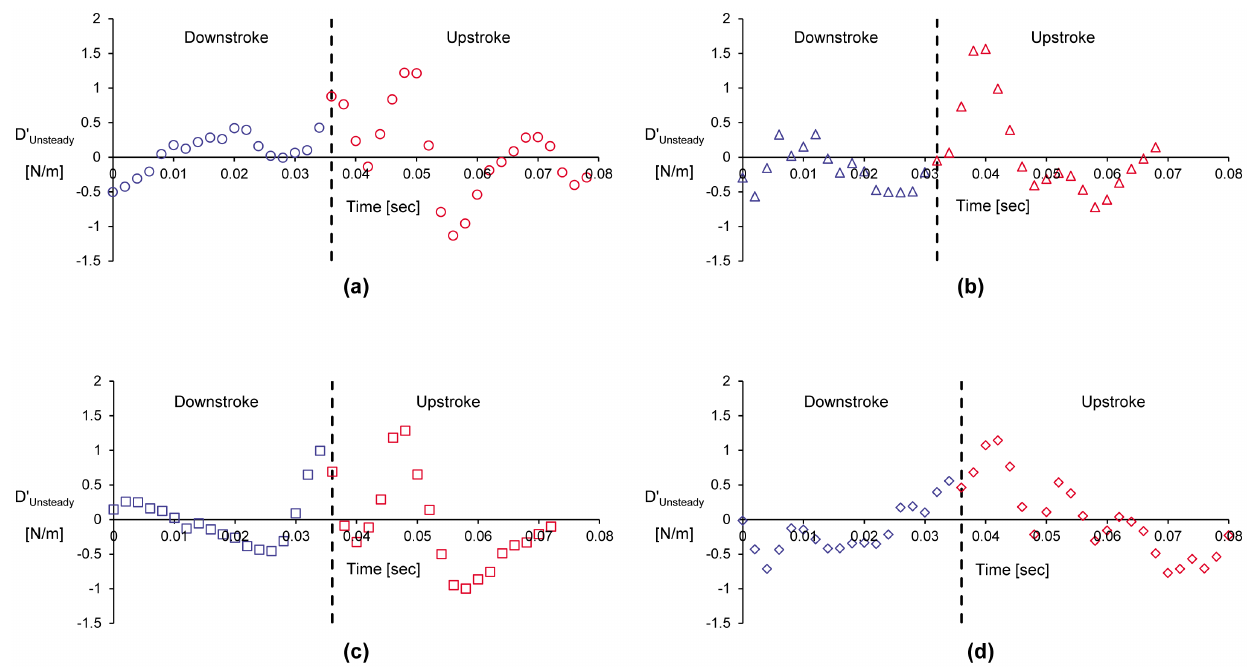
volume integral of h u/ h t appears to be positive; however, once the steady drag reach a maximum value halfway through the upstroke (Figure 13), the unsteady drag once more becomes negative indicating that h u/ h t . 0, as it was during the downstroke.